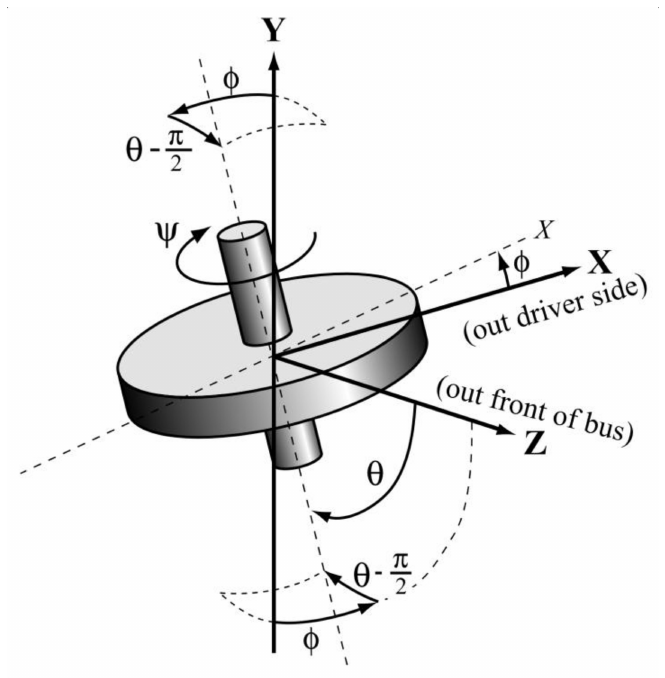
Figure 28. Mathematical model and coordinate systems used to analyze flywheel gyrodynamics, adapted from